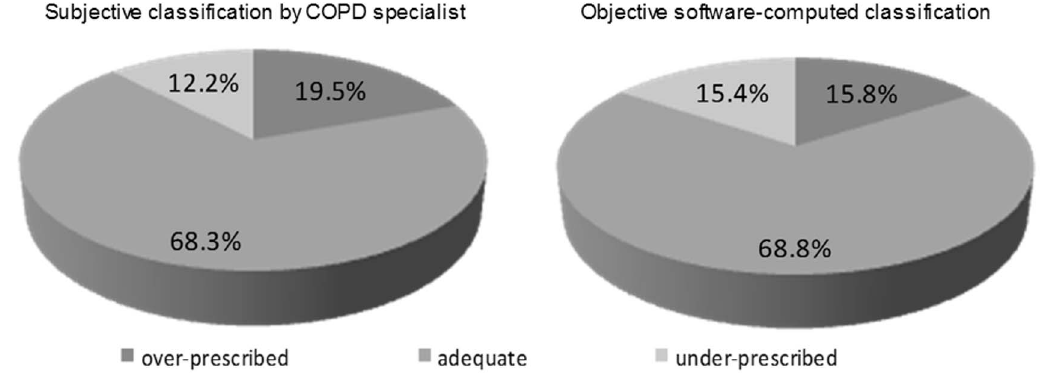
Figure 6. Comparison of ICS prescription related to the GOLD 2011 classification as done subjectively by COPD specialist and as objectively computed.